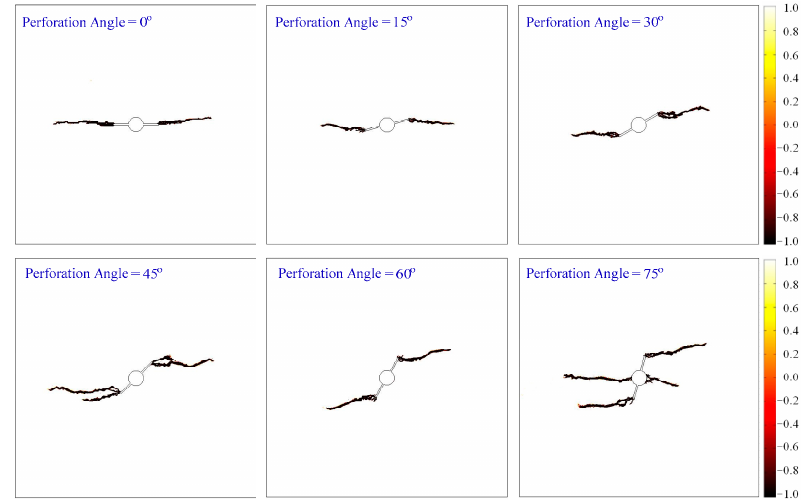
Figure 7. Numerical results of near-wellbore fracture patterns for different preexisting perforation angles.